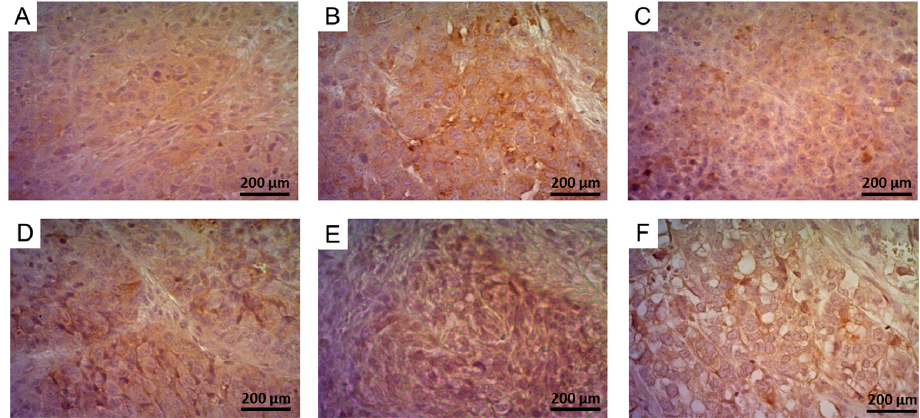
Figure 5. Immunohistochemistry results showing FR-expression in ( A ) HeLa; ( B ) KB; ( C ) KB-V1; ( D ) IGROV-1; ( E ) SKOV-3 and ( F ) SKOV-3.ip tumors. Tissue images are shown in magnification 40×.